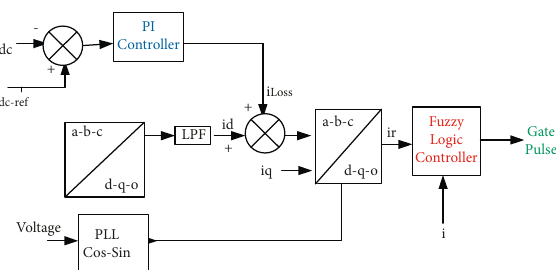
Figure 18: Synchronous reference frame SRF-DQ for reference current extraction RCE of harmonic to FLCC-based gate pulse for single-phase half-bridge